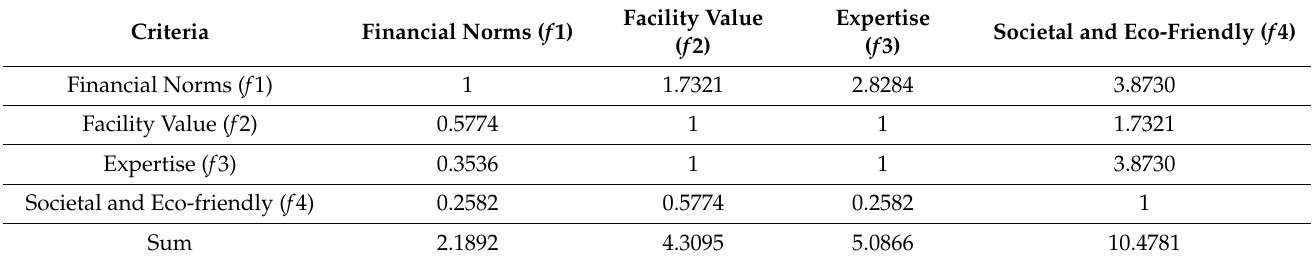
Table 9. Non-fuzzy comparison matrix.